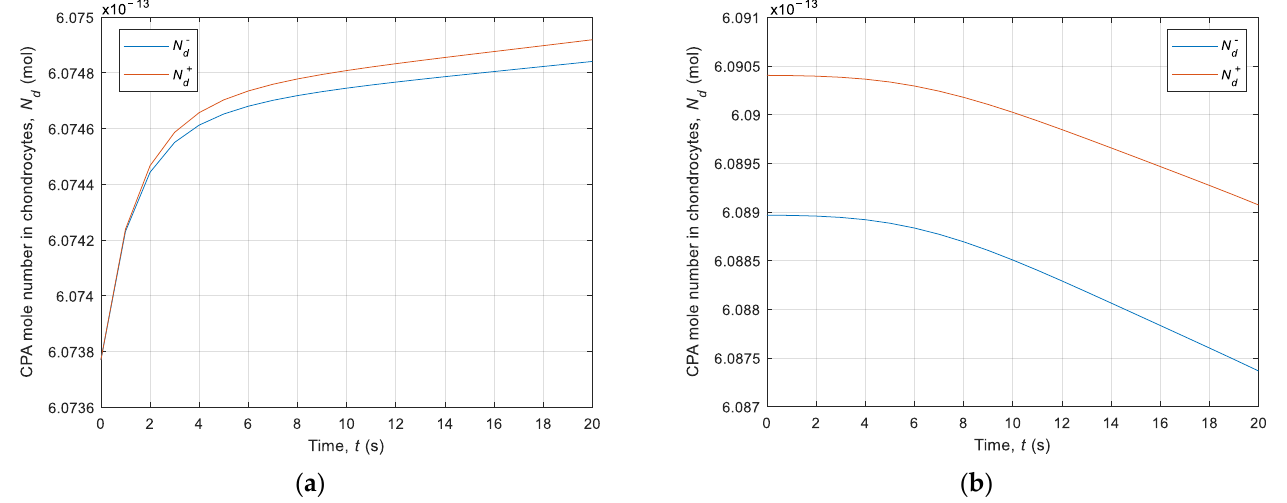
Figure 8. History of the intracellular CPA moles number over time: ( a ) from 22 C to −5 C; ( b ) from −5 C to 22 C.